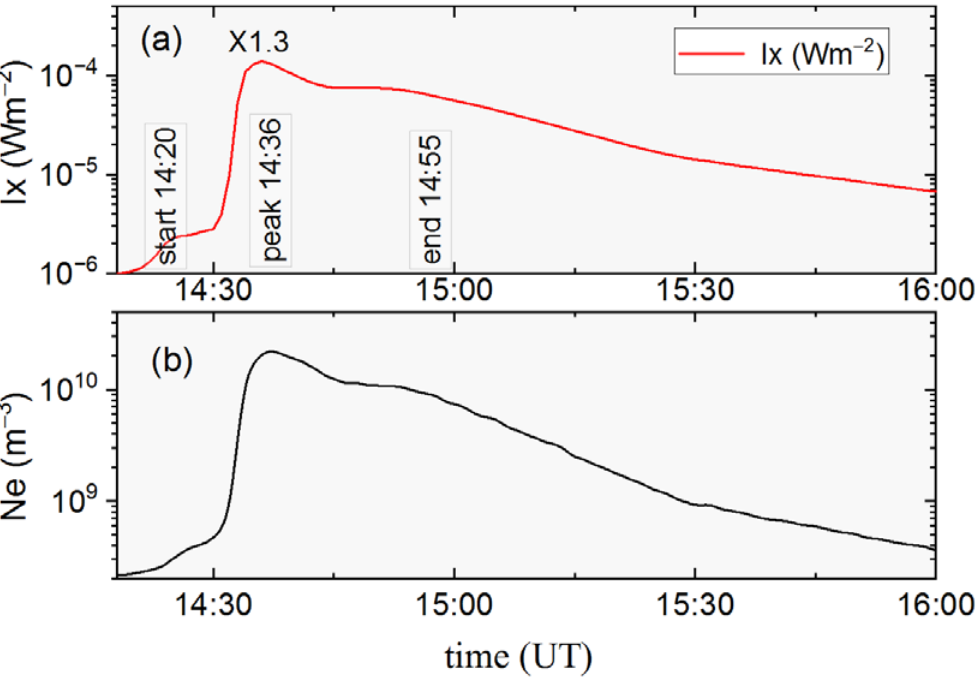
Figure 3. X -ray flux measured by the GOES satellite ( a ), and evaluated electron density profiles ( b ) during occurrence of X1.3 class SF on 7 September 2017 .